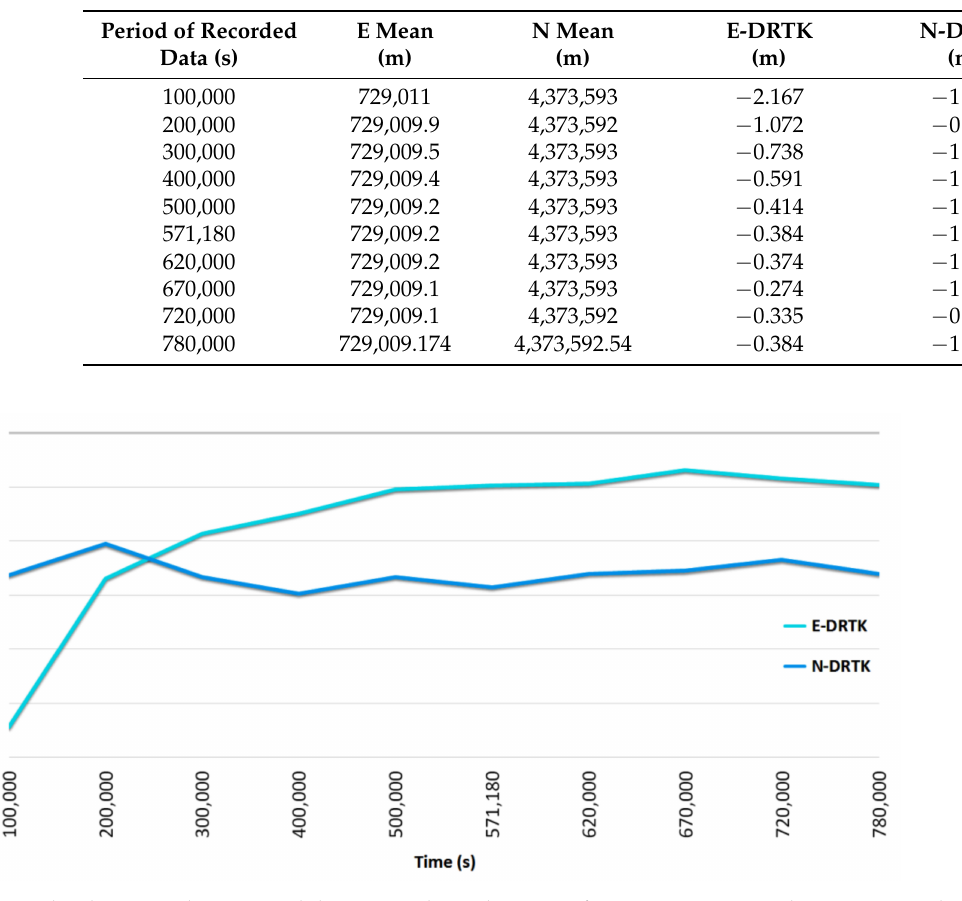
Figure A4. The relationship between the time and the East and North errors of Huawei Y330-U01 device. East and North errors are the differences between the control point and coordinate